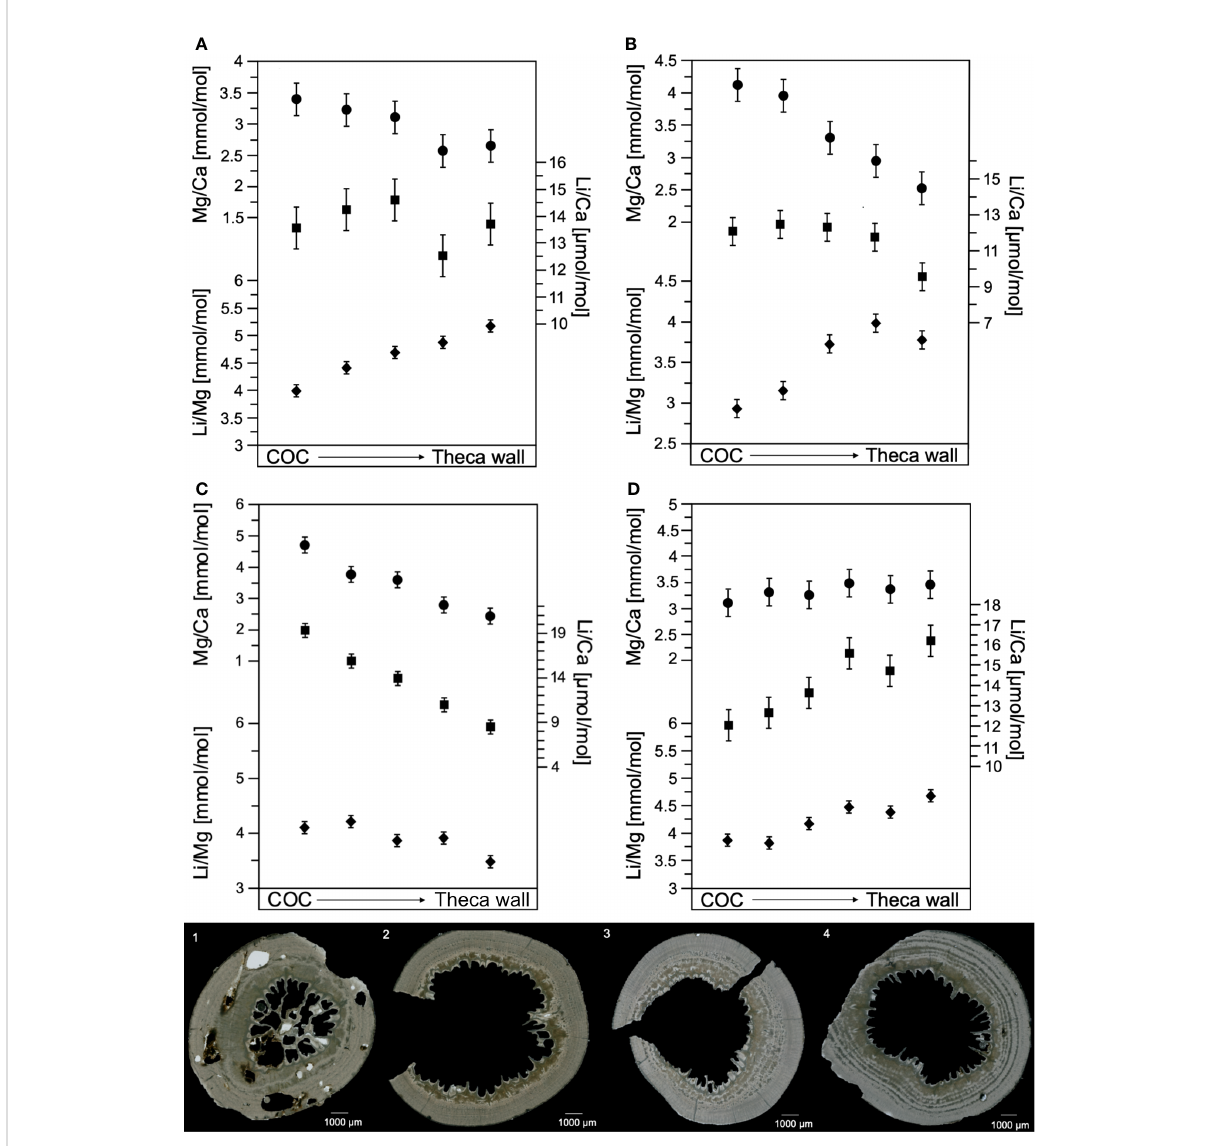
FIGURE 6 Elemental ratios Mg/Ca [mmol/mol], Li/Ca [ m mol/mol], and Li/Mg [mmol/mol], of four samples from the South Atlantic. The doubled standard variation for Mg/Ca ±0.25 mmol/mol, Li/Ca ±0.77 µmol/mol and Li/Mg ±0.11 mmol/mol was determined by JCp-1 measurements. Figures 1 – 4 below, show the cross-section of the analyzed sample with an allocation of 1-A, 2-B, 3-C and 4-D . Samples were collected by micromill starting at the COC structure ongoing until the theca wall.